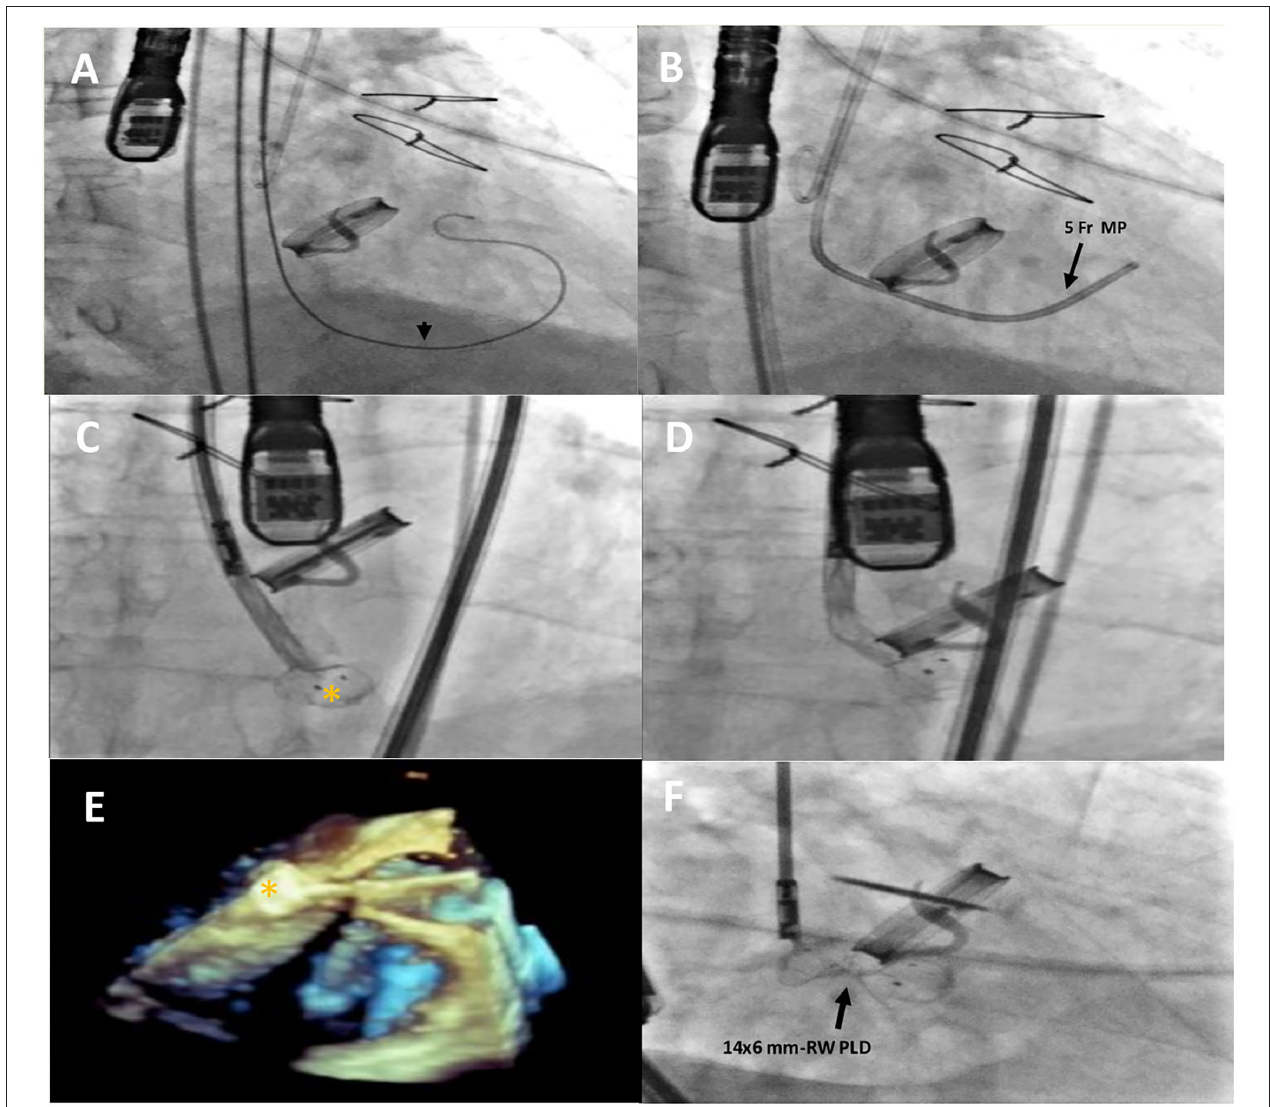
FIGURE 2 | Intraprocedural fluoro-angiographic and real-time 3D TEE procedural steps showing the guide wire (A) (black arrowhead) across the leakage with the distal soft tip in the left ventricle; the 5- Fr multipurpose catheter in the LV (B) ; the distal disc device opening (orange asterisk) (C–E) and the 14 × 6mm rectangular waist PLD correctly positioned and still anchored to the delivery cable (F) . MP, multipurpose catheter; PLD, Occlutech Parvalvular Leak Device; RW, rectangular